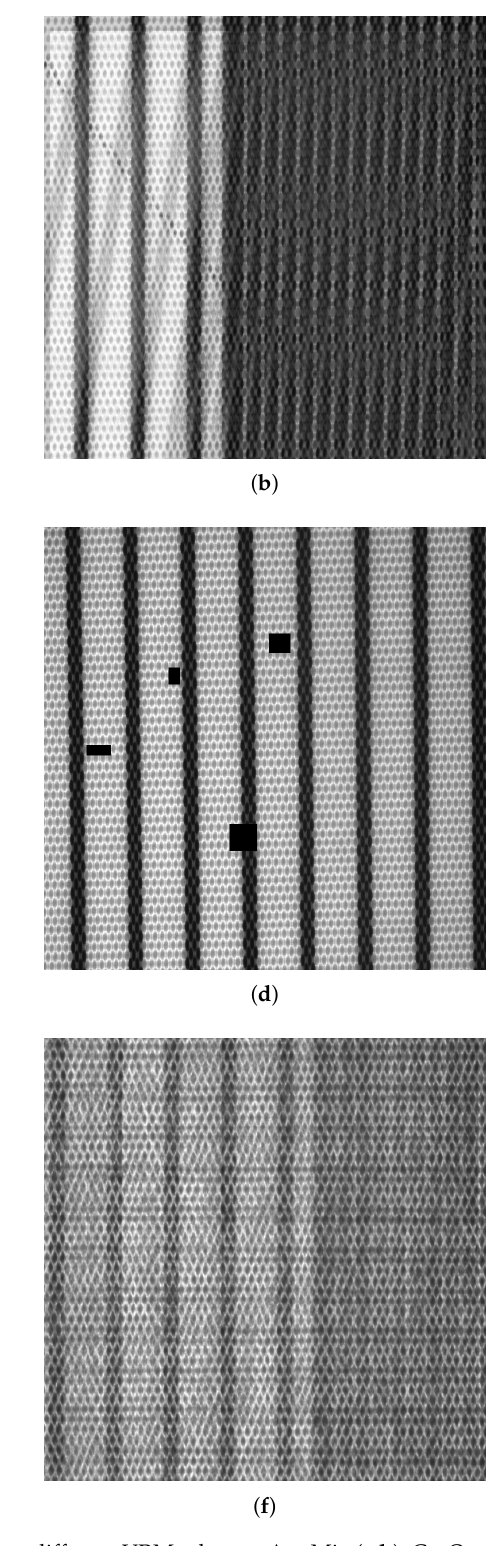
Figure 4. Representative results of applying the three different VRM schemes AugMix ( a , b ), CutOut ( c , d ) as well as MixUp ( e , f ). For the back-light images ( b , d , f ), the “red” color channel is displayed as a grayscale image, encoding light transmission, whereas light reflectance is shown as RGB images ( a , c , e